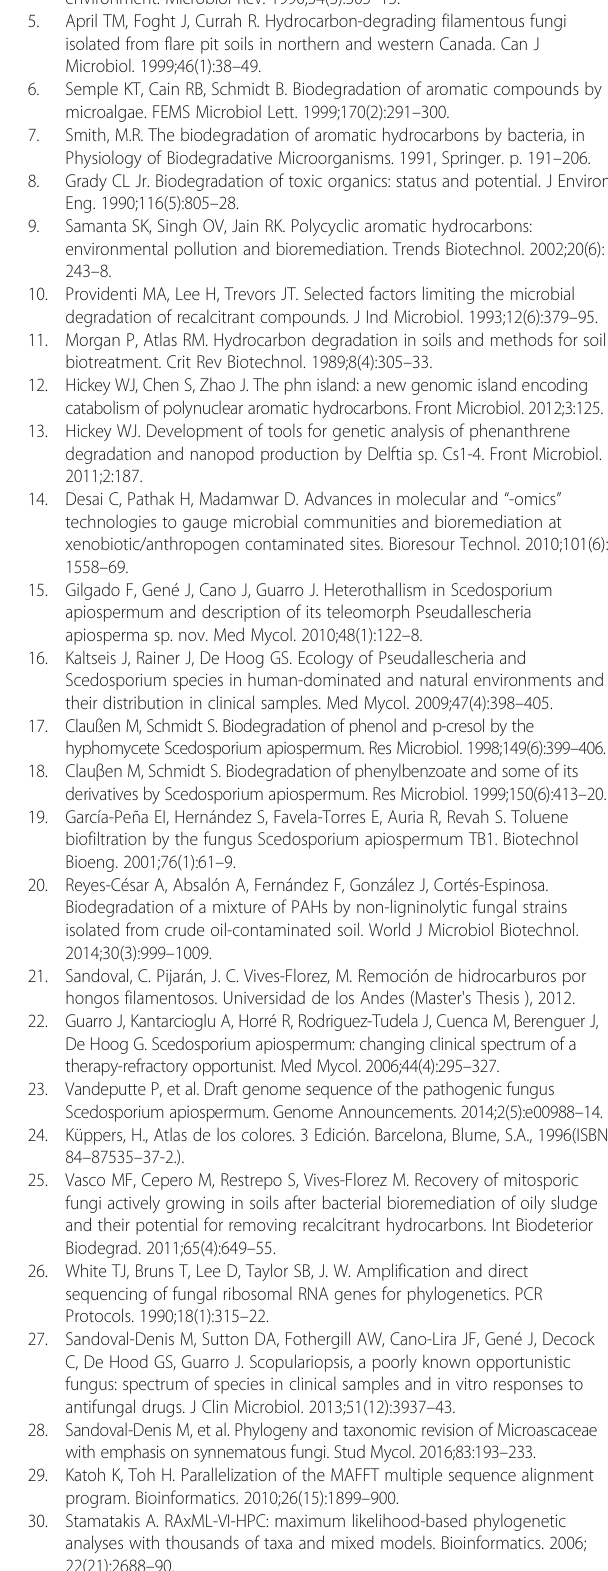
Additional file 1: Table S1. Genome assembly statistics reported by Quast [44]. Table S2. Non-coding repeats sequences summary. Table S3. Species and genes (accession numbers) used in the phylogenetic analysis [29]. (DOCX 37